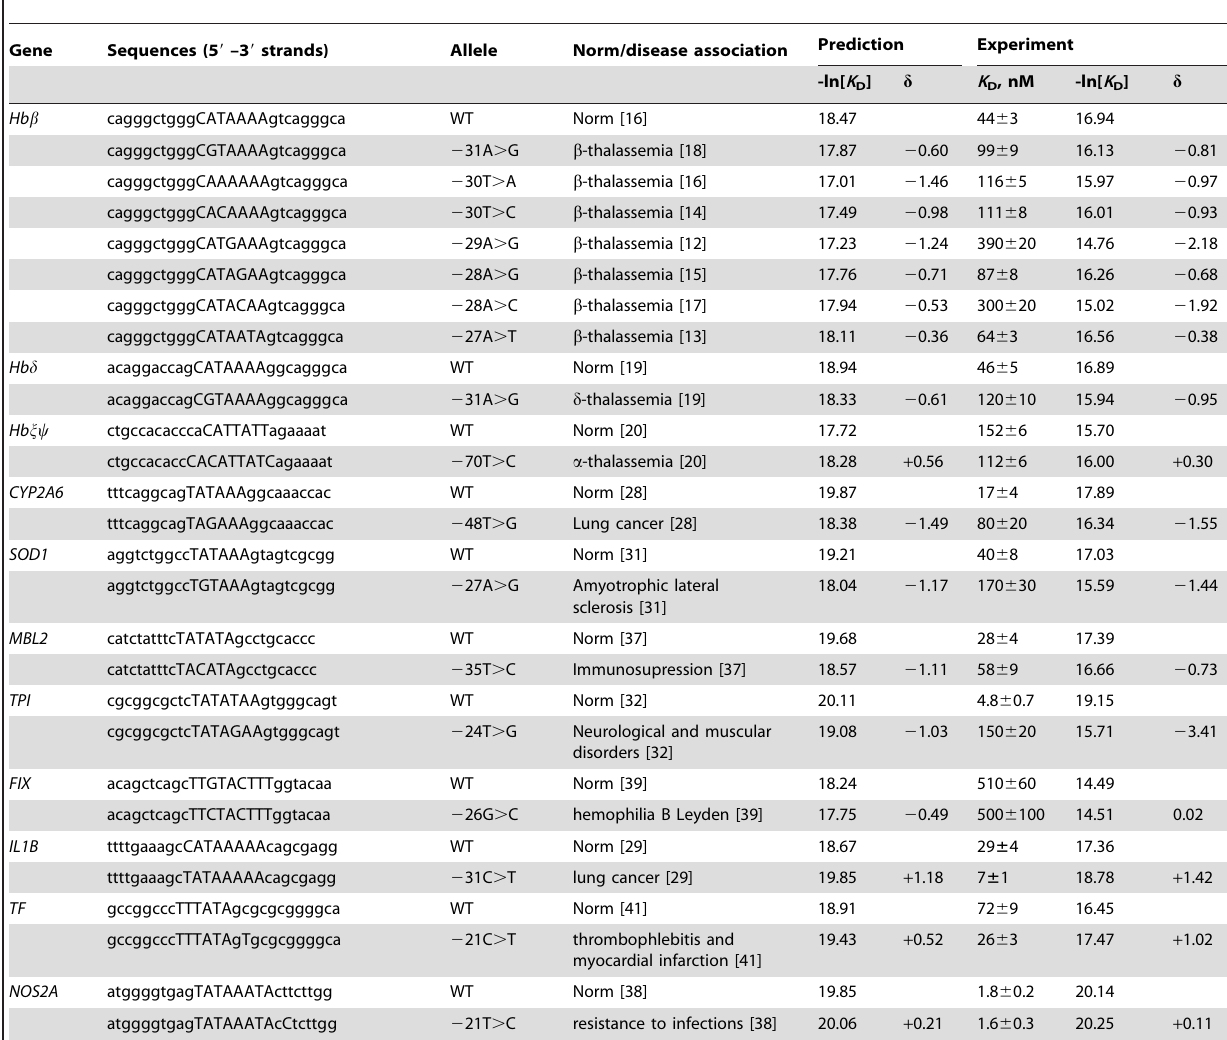
Table 1. The experimental verification of predicted changes in K D for TBP/TATA when the TATA boxes contain SNPs associated with human diseases.